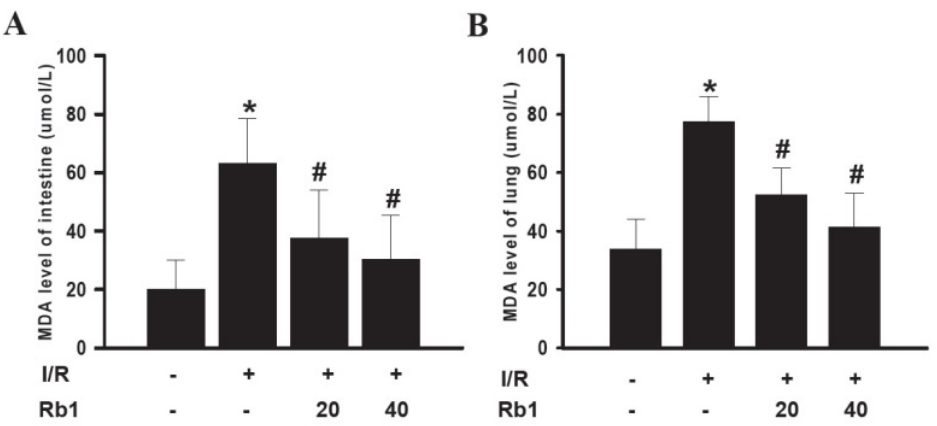
Figure 4. Effects of Rb1 on MDA levels of intestinal and lung